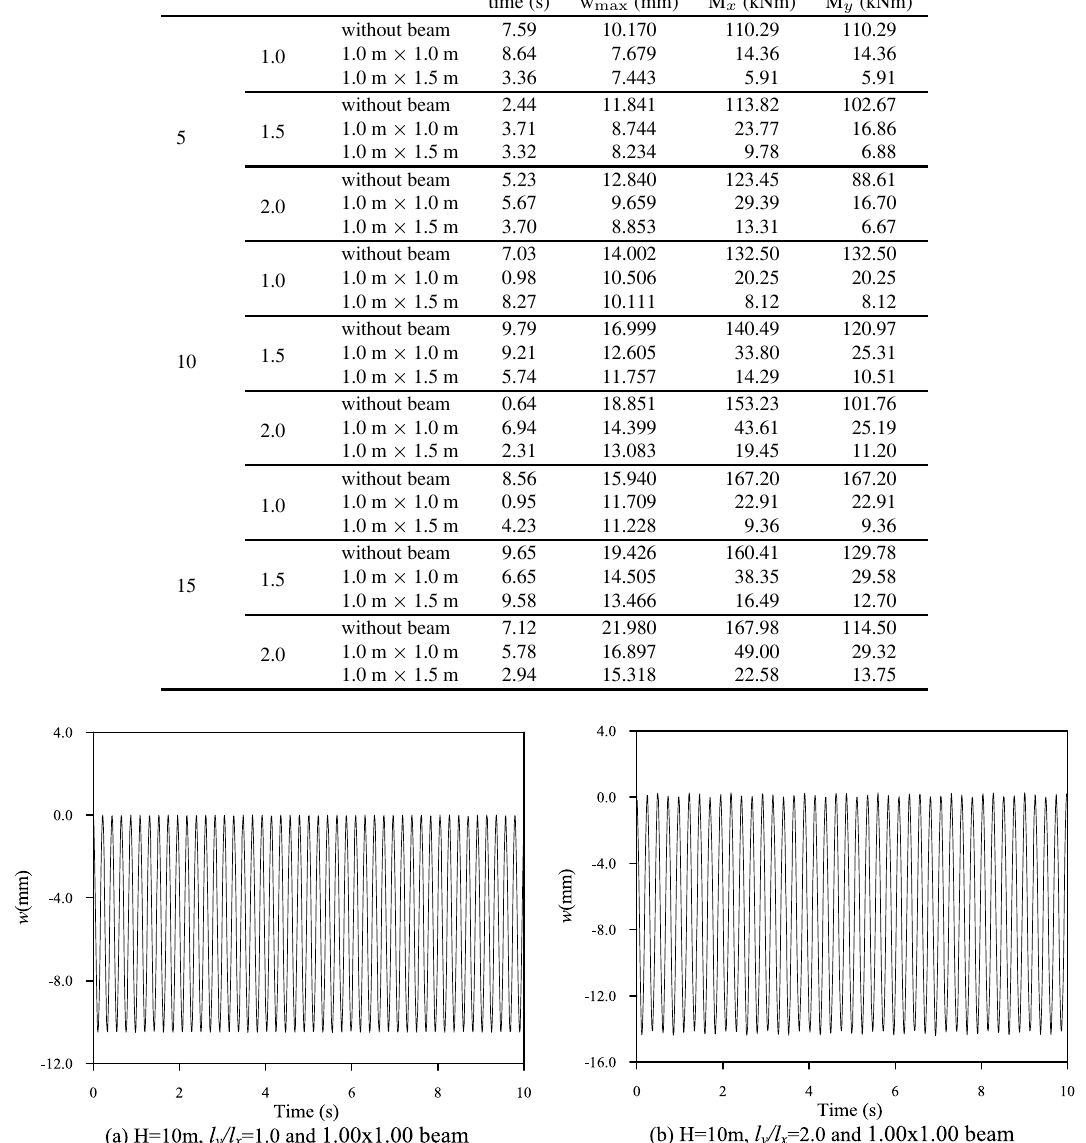
Fig. 6. The time histories of the center displacements of the